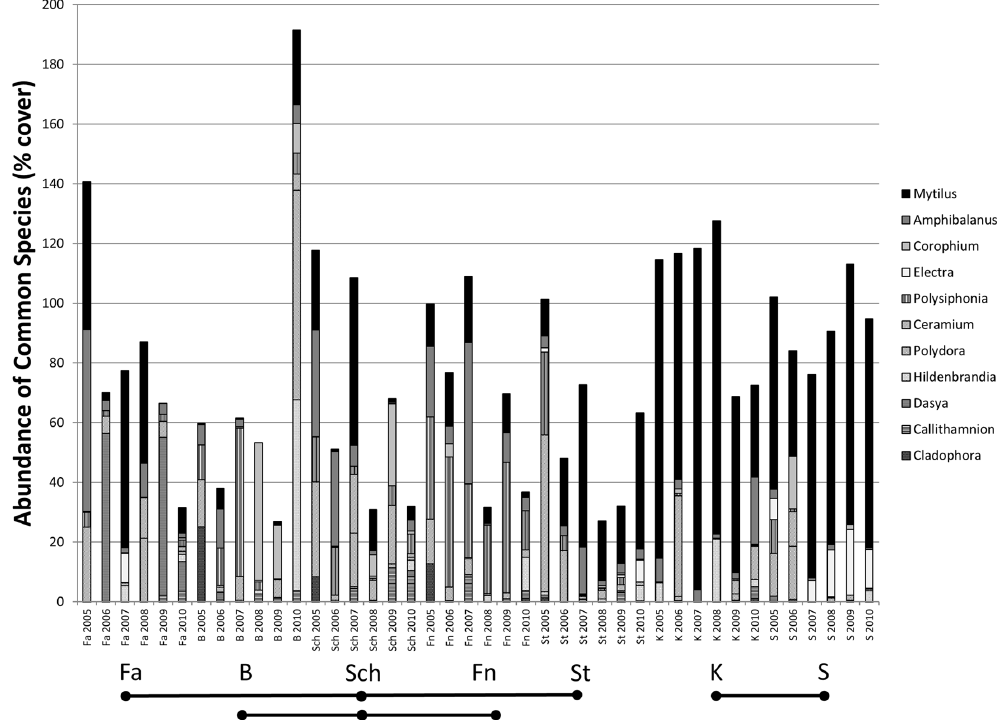
Fig. 6. Mean cover (%) of the more common species at the 7 stations and in the 6yr of surveillance. Station dots connected by lines at the base of the graph do not differ significantly in community composition.